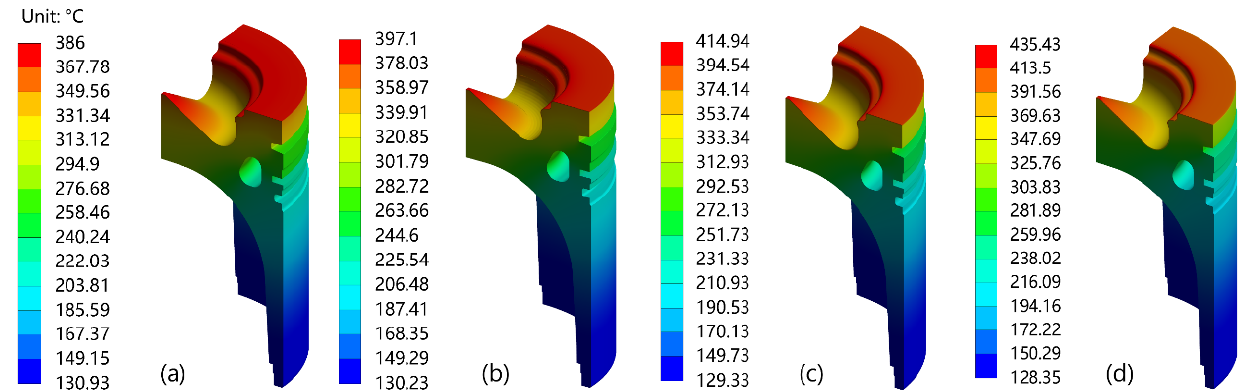
Figure 7. Temperature distribution of topcoat surface for various coating thicknesses: ( a ) 0.2 mm, ( b ) 0.3 mm, ( c ) 0.5 mm, ( d ) 0.7 mm.